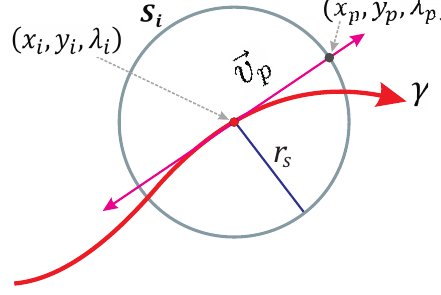
Figure 4. Euler’s predictor